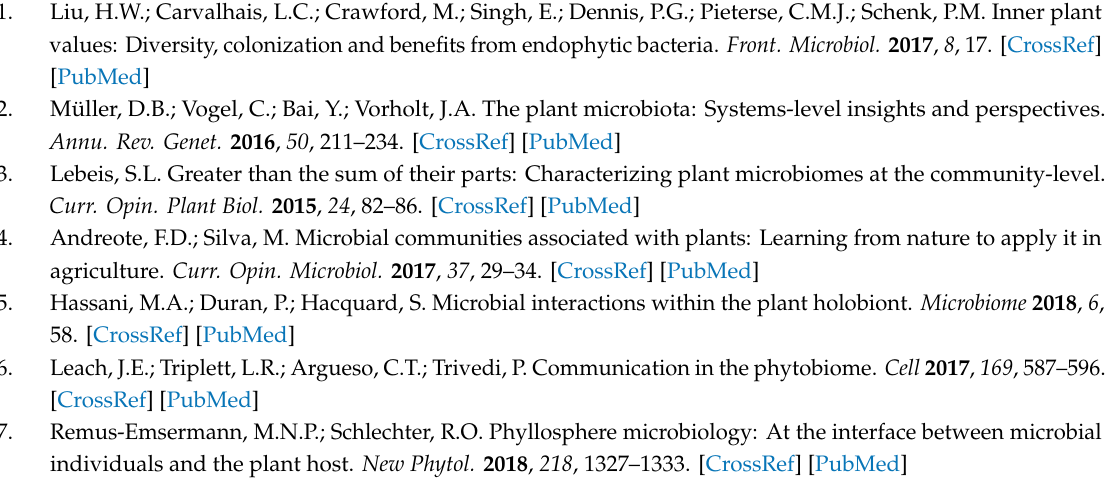
Supplemental Figure S1: Exemplary MALDI-TOF MS profiles obtained from strains that all were identified as Pediococcus pentosaceus . The strains were isolated from the phyllosphere of four di ff erent plant species, as shown in the figure. Some strain-specific peak patterns are indicated by boxes. Supplemental Figure S2: Heatmap of genus absence-presence patterns (respectively white and black) is shown for the microbiome of Lepidium sativum phyllosphere of two independent experiments (Repl_1, Repl_2) comprising four replicates each. Genus-specific OTUs were clustered regarding their binary absence-presence pattern, using the binary method of the R dist() function, whereas the samples were grouped based on the UPGMA clustering